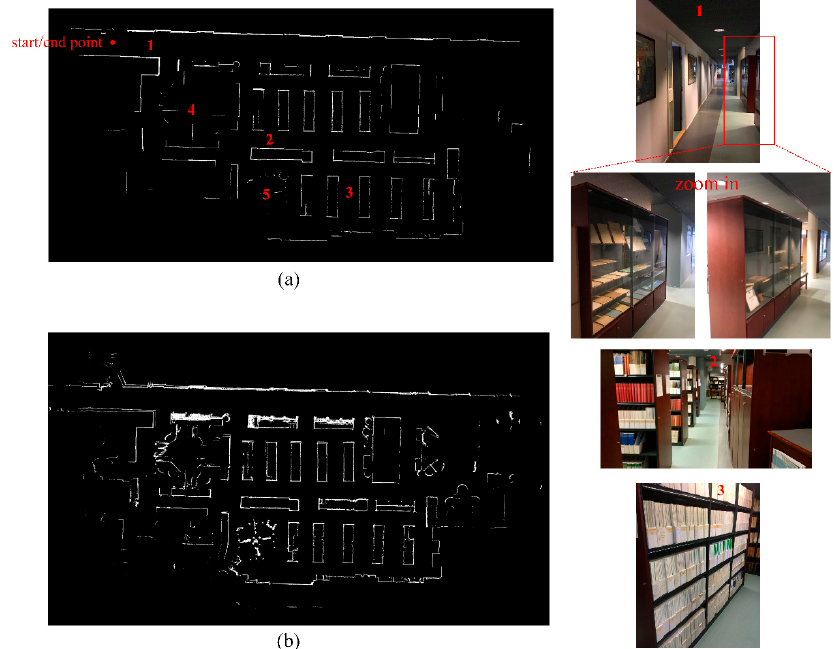
Figure 6. Comparative results of our proposed OWOLM (a), the traditional OLM (b) approach, and five scene photos of three places. In (a) and (b), brighter intensities indicate higher likelihood values .